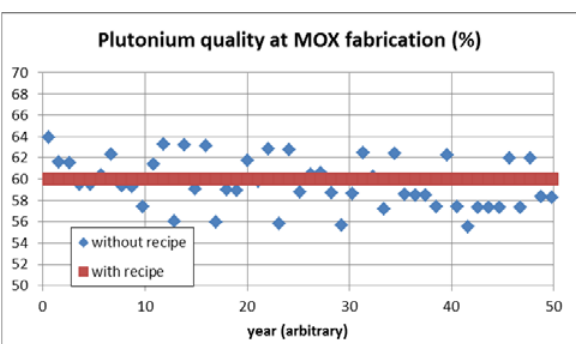
Figure 5. Application of recipe model to PWR MOX fuel